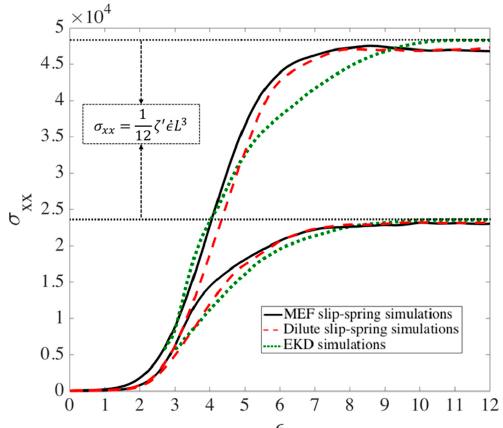
Figure 10. Extensional stress in x-direction ( σ xx ) for chains of length N s = 32 (lower set of curves) and N s = 64 at Wi R = 32 (upper set of curves). Black lines are obtained under the MEF assumption while the dashed red lines are for chains without slip-springs; i.e., dilute chains. EKD results, plotted starting from the transition strain (cid:101) = 3, are shown with green dotted lines. The two horizontal dotted lines show the theoretical final stress value that an entangled or unentangled chain will achieve when fully unraveled. The results for both slip link methods and EKD are averaged over an ensemble of 150